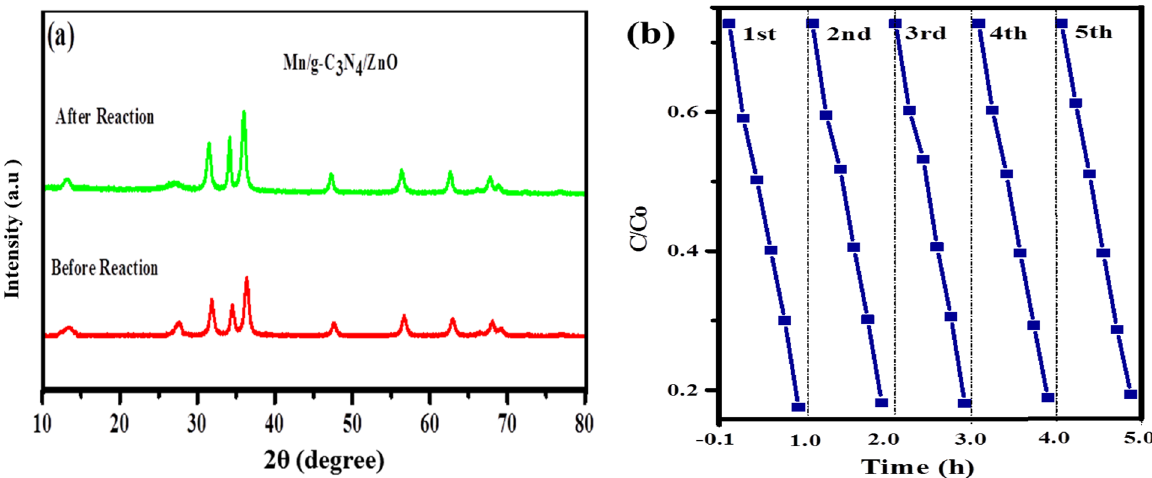
Figure 11. XRD analysis of Mn/50GZ NCs ( a ) and the recyclability test ( b ) after the fifth cycle